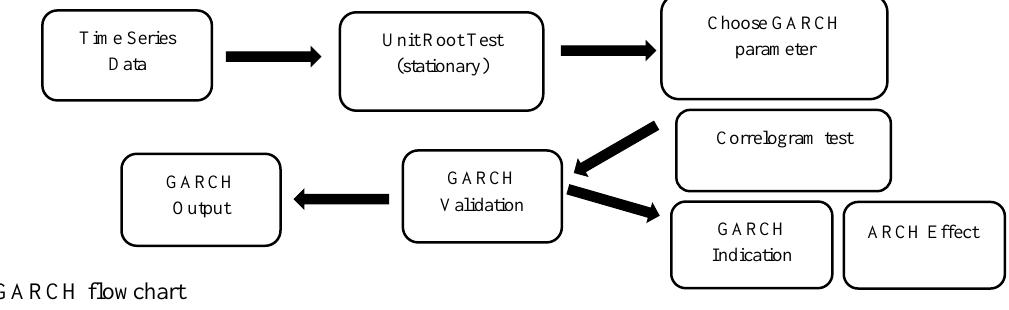
Figure 2: GARCH flowchart